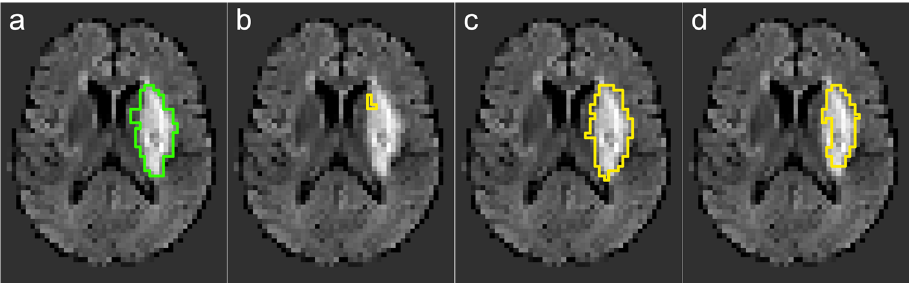
Fig 8. Case with low agreement between methods in flair scenario. (a) 18/28 ground-truth (GTG). (b) 18/ 28 AdaBoost. (c) 18/28 CNN. (d) 18/28